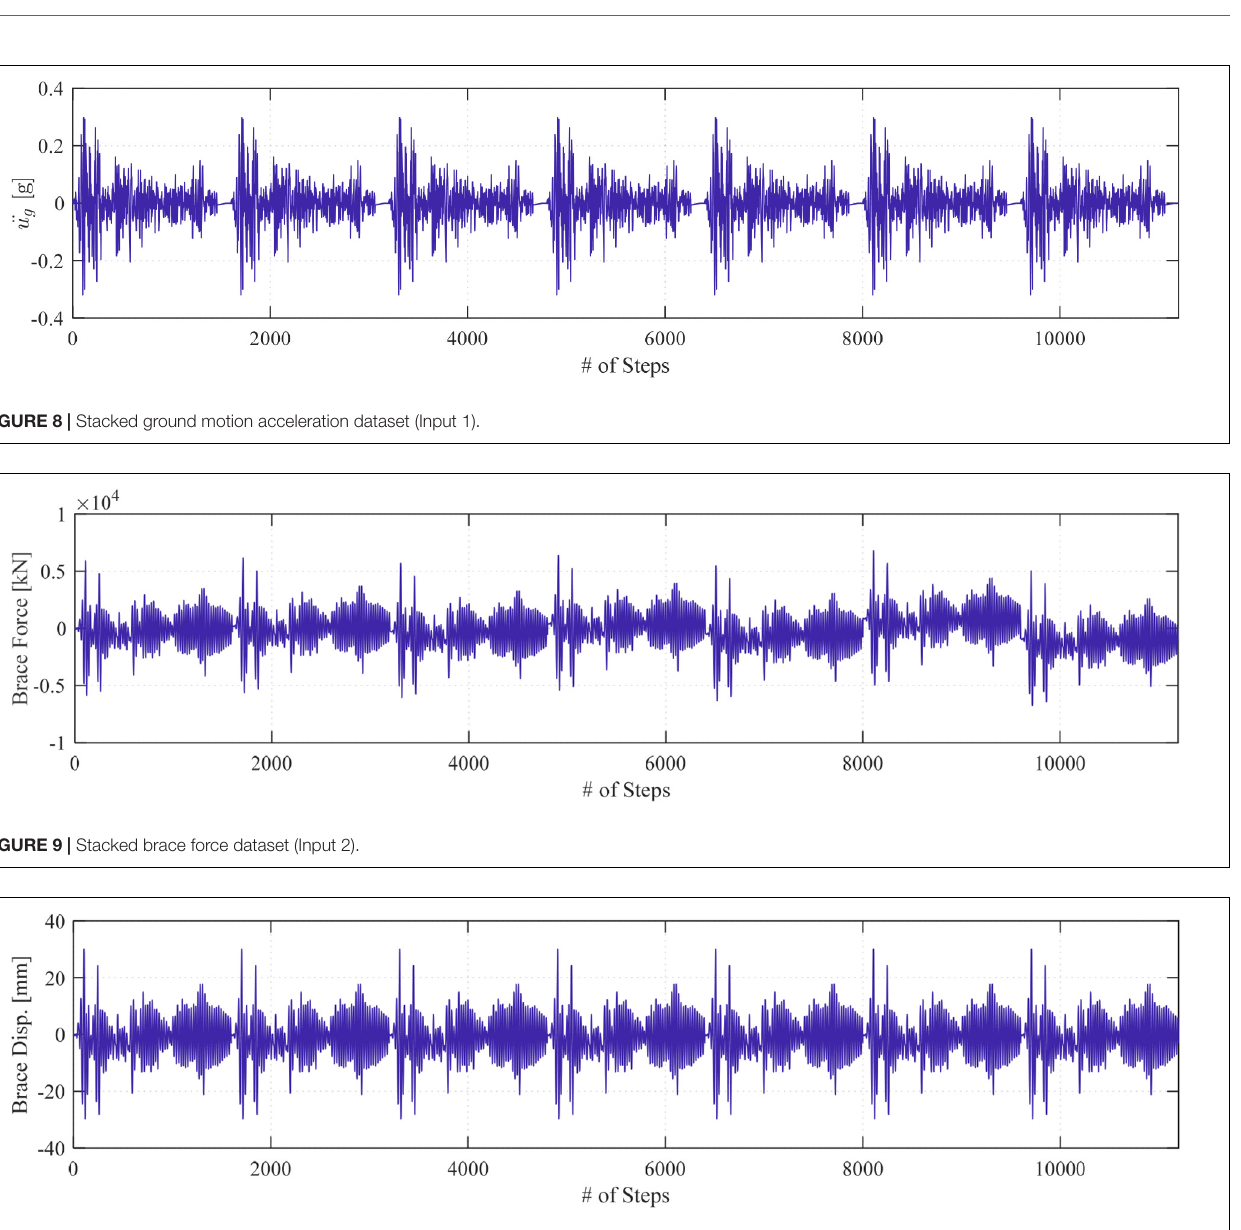
FIGURE 10 | Stacked brace displacement dataset